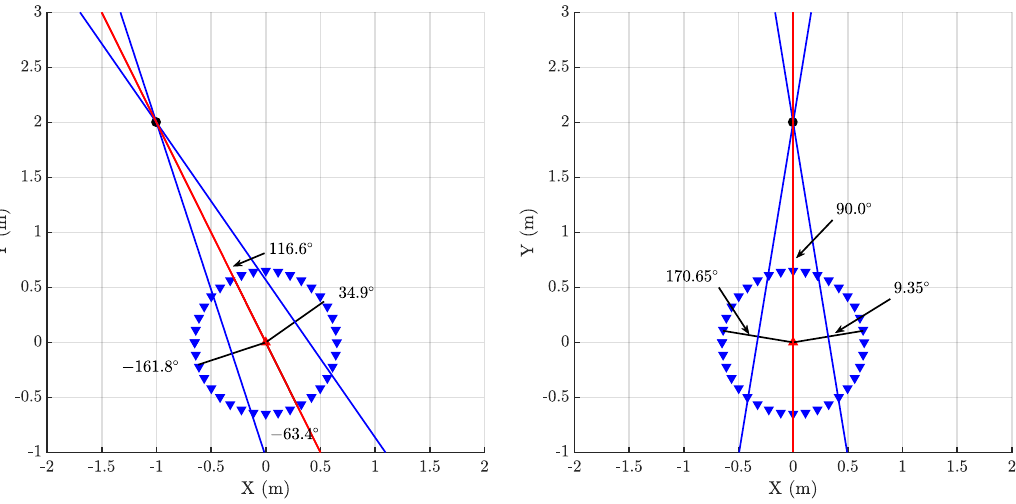
Figure 5. Positions of source 1 ( left ) and source 2 ( right ) and the theoretical zero-crossing and bearing